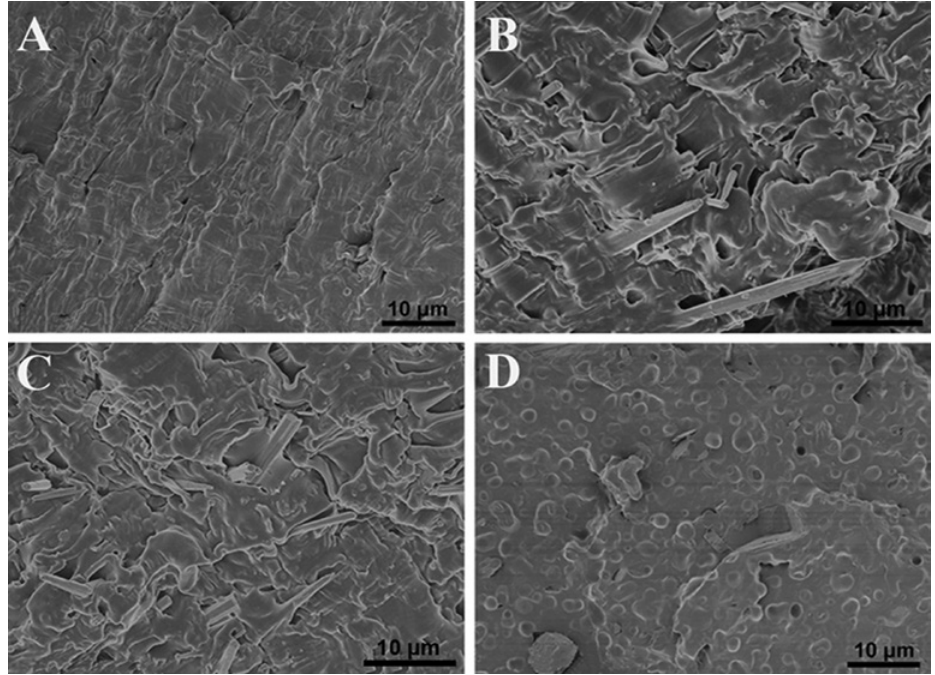
Figure 5: FESEM micrographs of fracture surface of a broken Izod sample: (A) PP, (B) PP/CWs, (C) PP/AWs, (D)